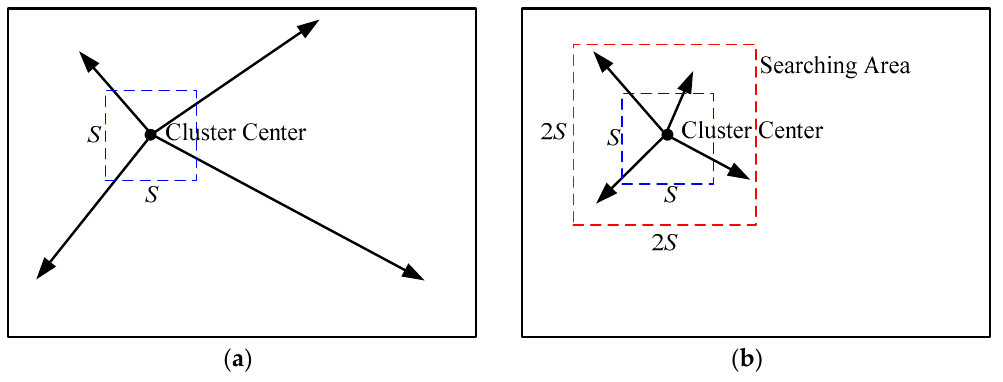
Figure 1. Illustrations of search areas of cluster center in ( a ) conventional k-means clustering (KMC) and ( b ) local KMC used in the simple linear iterative clustering (SLIC) algorithm.